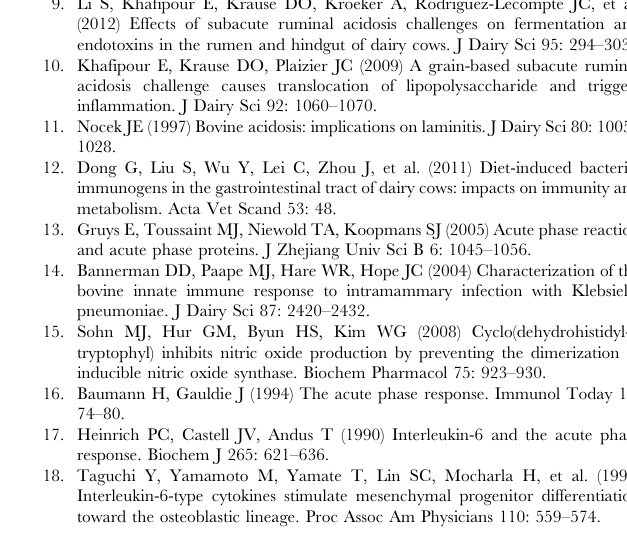
Figure S1 Co-expression network for immune and inflammatory responses in the liver of LC goats. (TIF) Figure S2 Co-expression network for lipid metabolism in the liver of LC goats. (TIF) Figure S3 Co-expression network for protein (or amino acid) metabolism in the liver of LC goats. (TIF) Figure S4 Co-expression network for carbohydrate metabolism in the liver of LC